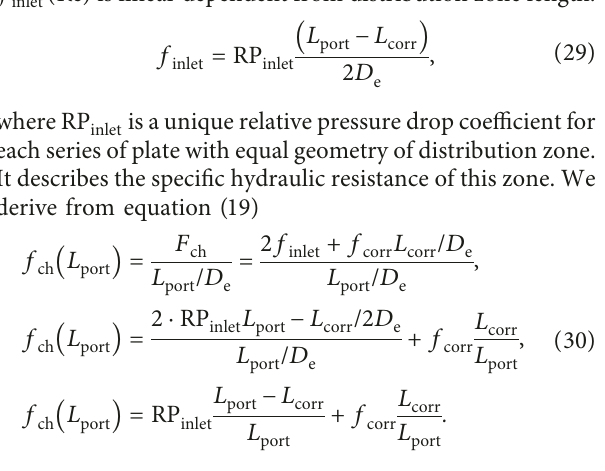
Figure 10: Fanning friction factor f HH corrugated